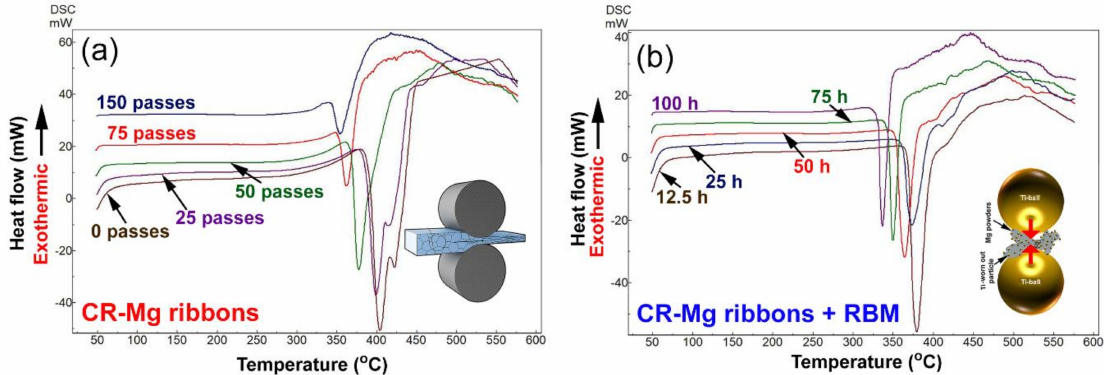
Figure 11. Di ff erential scanning calorimeter (DSC) thermograms of Mg-ribbons ( a ) obtained after CR for di ff erent passes (0, 25, 50, 75, and 150 passes), and then hydrogenated at 300 ◦ C, and ( b ) obtained after CR for 150 passes, and then RBM under hydrogen gas pressure for 12.5, 25, 50, 75, and 100 h of RBM